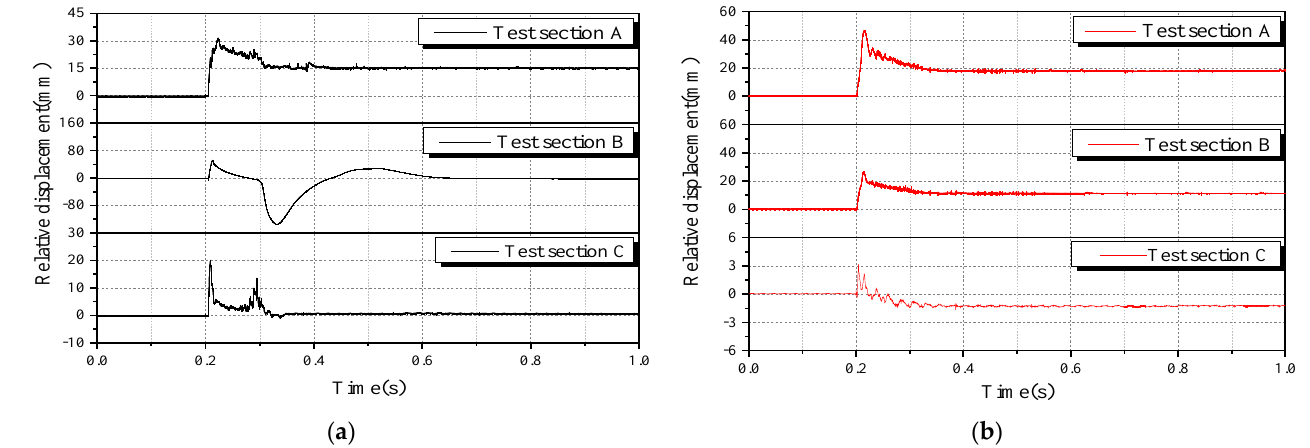
Figure 13. The time – history curves of the relative displacement of the structures: ( a ) the vertical relative displacement; ( b ) the transverse relative displacement.